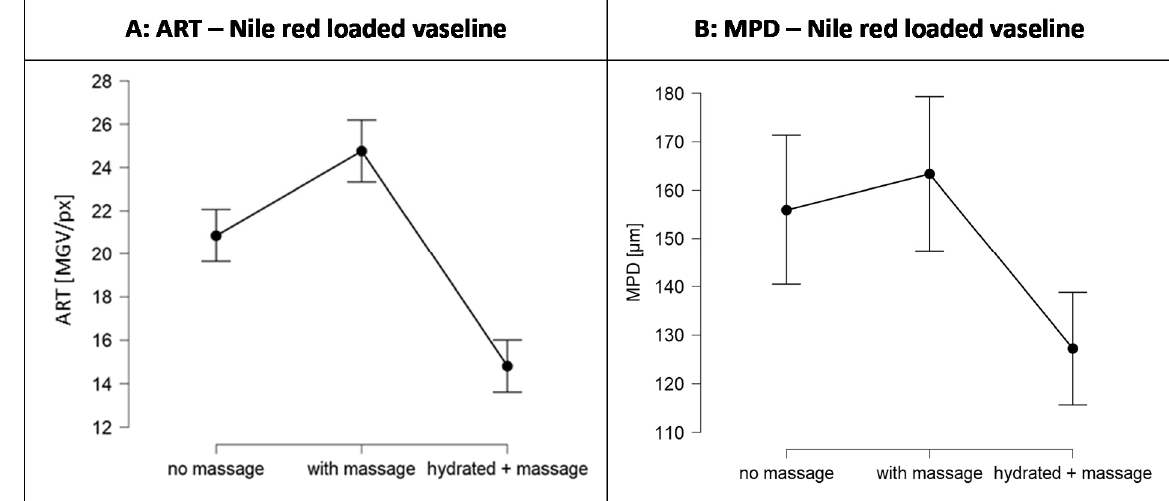
Figure 5. Images obtained from epifluorescence microscopy of the skin sections without Vaseline treatment (blank) and of the skin sections treated with Vaseline loaded with Nile red (middle row—original images, lower row—images after automated RGB Threshold). Scale bare = 50 µm.